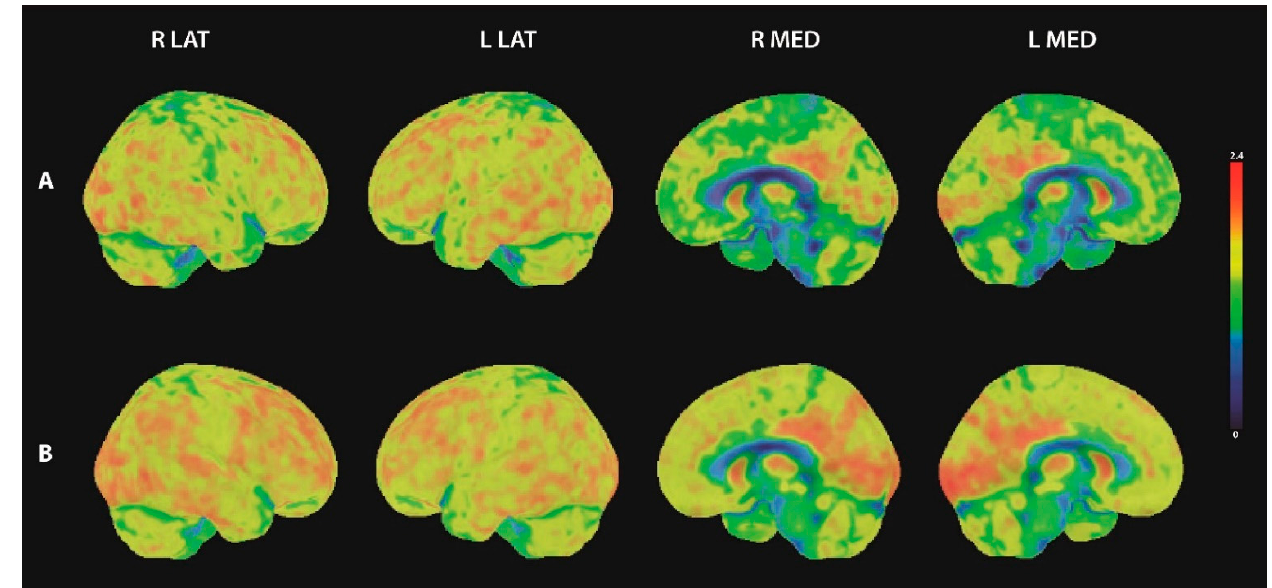
Figure 2. 18F-FDG-PET images of the brain. Three-dimensional surface projections of FDG-uptake in lateral and medial view. ( A ) initial 18F-FDG-PET scan showed bilateral hypometabolism prefrontal medial and parietal, ( B ) follow up 18F-FDG-PET showed physiological cerebral FDG uptake. R lat = right lateral view; L lat = left lateral view; R med = right medial view; L med = left medial view.